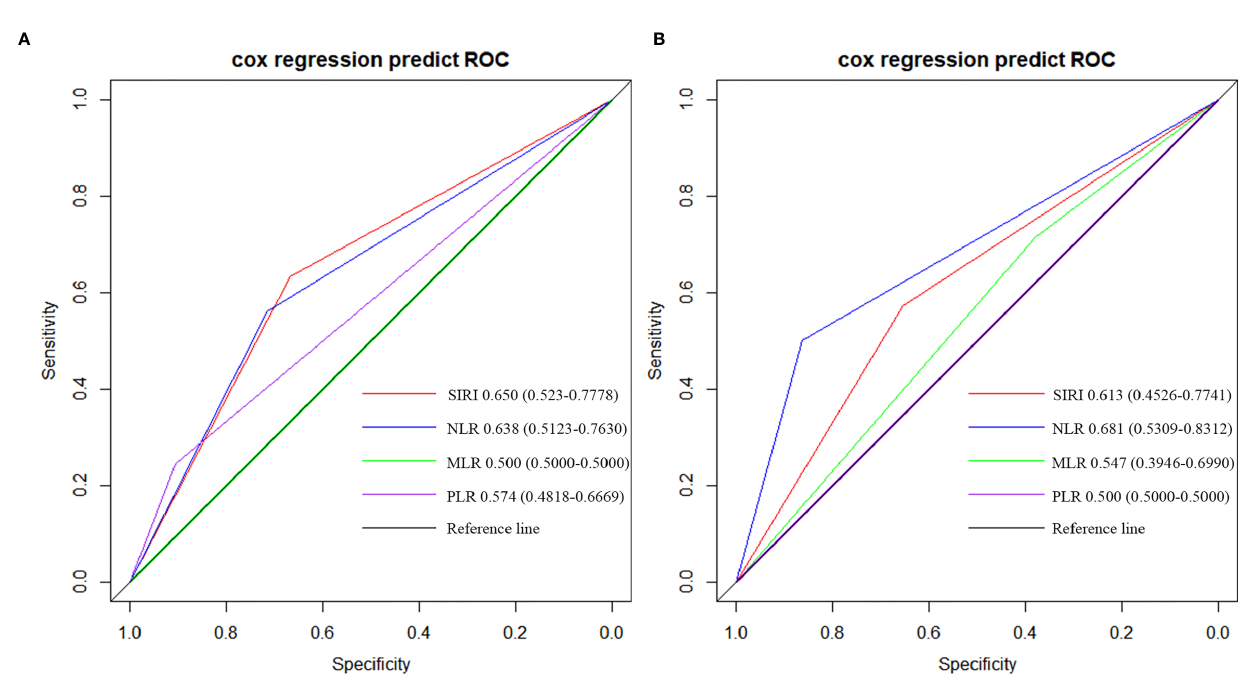
FIGURE 3 | Predictive ability of the SIRI, NLR, MLR, and PLR in operable (A) grade IV and (B) grade III glioma patients by ROC